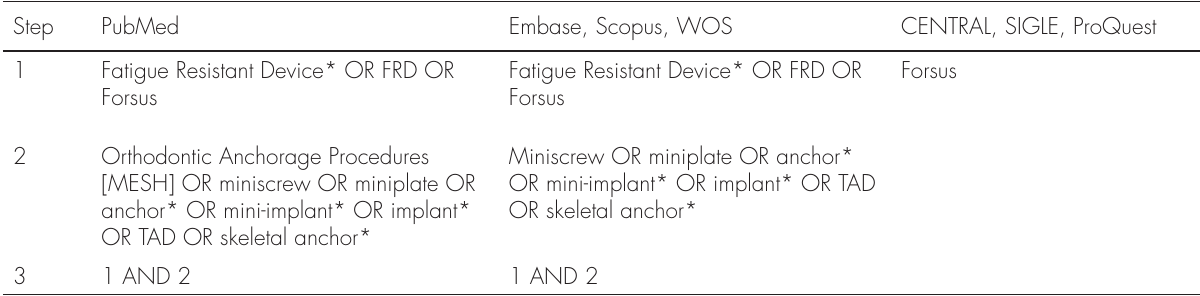
Table I. Search strategies for electronic